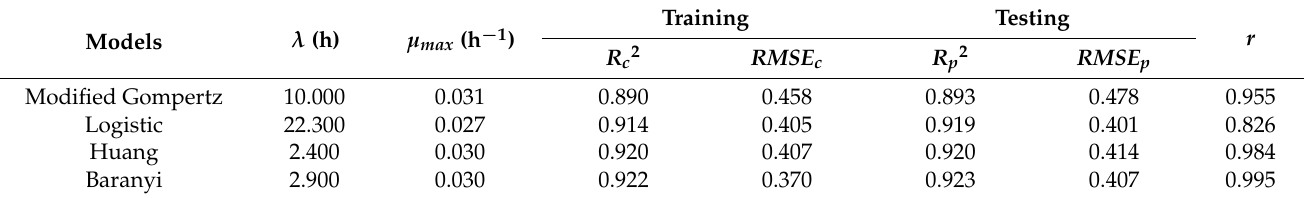
Table 5. Different kinetic-fitting models and parameters of E-nose sensor S7 in freshly squeezed strawberry juice during cold